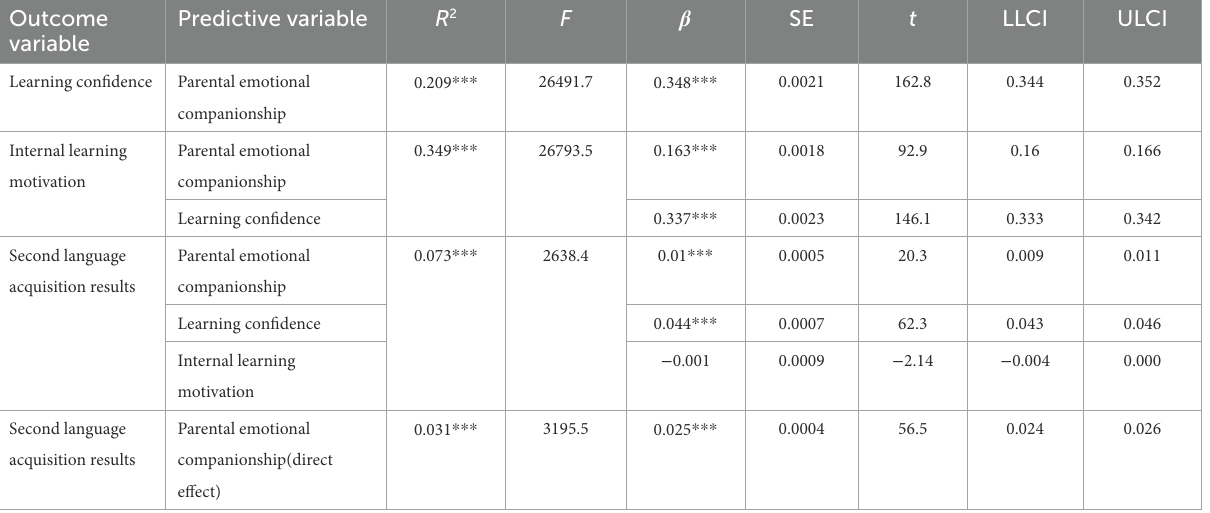
TABLE 4 Regression results of each variable in the middle school